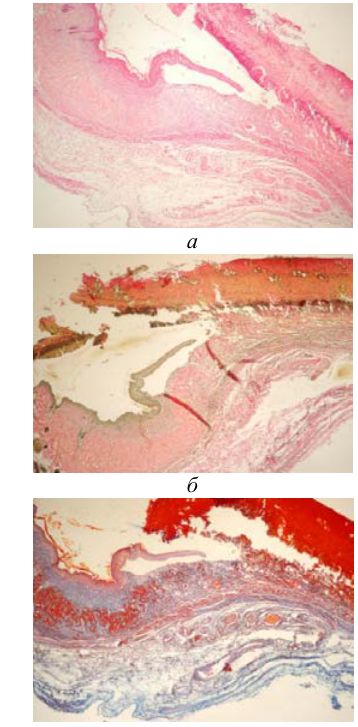
Рис . 7. Дослідна група щурів , яких лікували гелем тітріол : зона термічного пошкодження покрита струпом , нижче – пласт грануляційної тканини і шар колагенових волокон з чітко визначеною сіткою з еластичних волокон : а – забарв